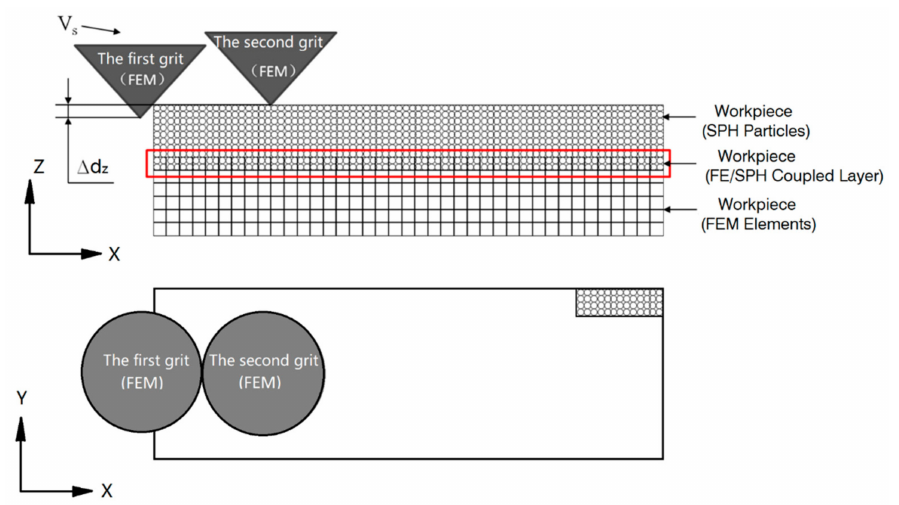
Figure 3. Simulation model of double scratching.